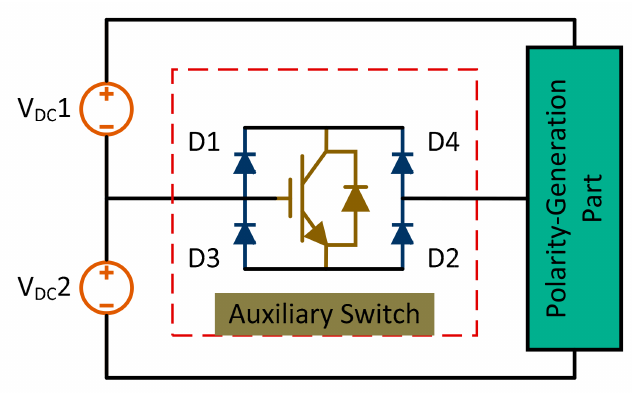
Figure 13. Topology of T-type symmetric H-bridge